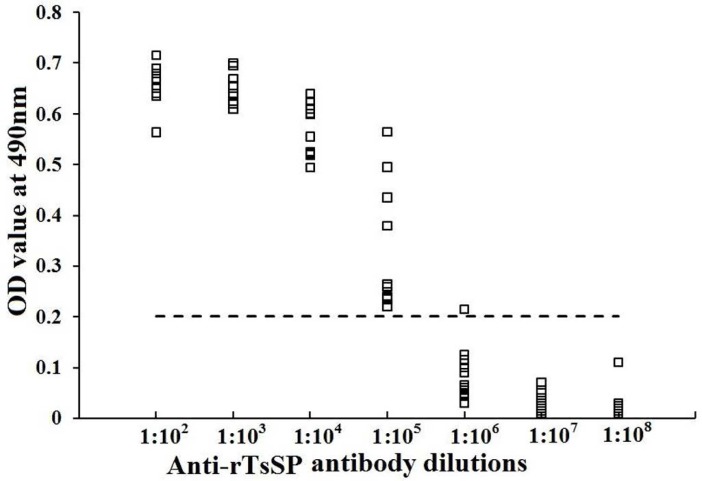
Serum anti-rTsSP IgG titers determined by ELISA.Microtiter plates were coated with 2 μg rTsSP /ml and incubated overnight at 4°C. After being blocked with 5% nonfat milk, the plates were incubated at 37°C for 1 h with different dilutions of immune sera. Normal mouse sera (n = 20) diluted at 1:100 were assayed as negative controls. HRP-conjugated IgG was utilized as the second antibodies. The coloration was developed by incubation with the substrate OPD. The absorbance at 490 nm was assayed following adding 2 M H2SO4. The cut-off values (0.202) are expressed with a dotted line.